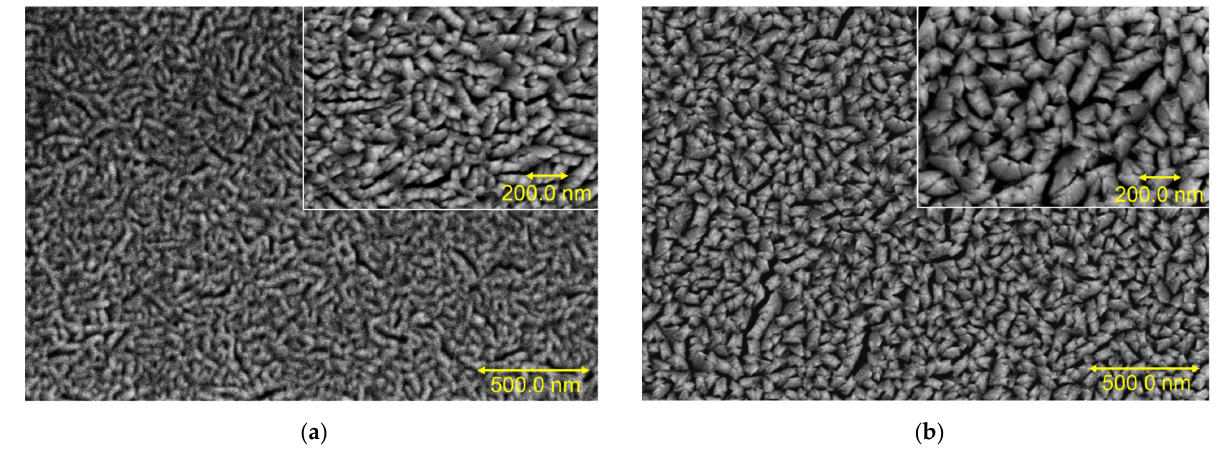
Materials 2023 , 16 , x FOR PEER REVIEW Figure 3. FESEM images of sputtered Mo films at: ( a ) 80 W and ( b ) 140 W. Figure 3. FESEM images of sputtered Mo films at: ( a ) 80 W and ( b ) 140 W.